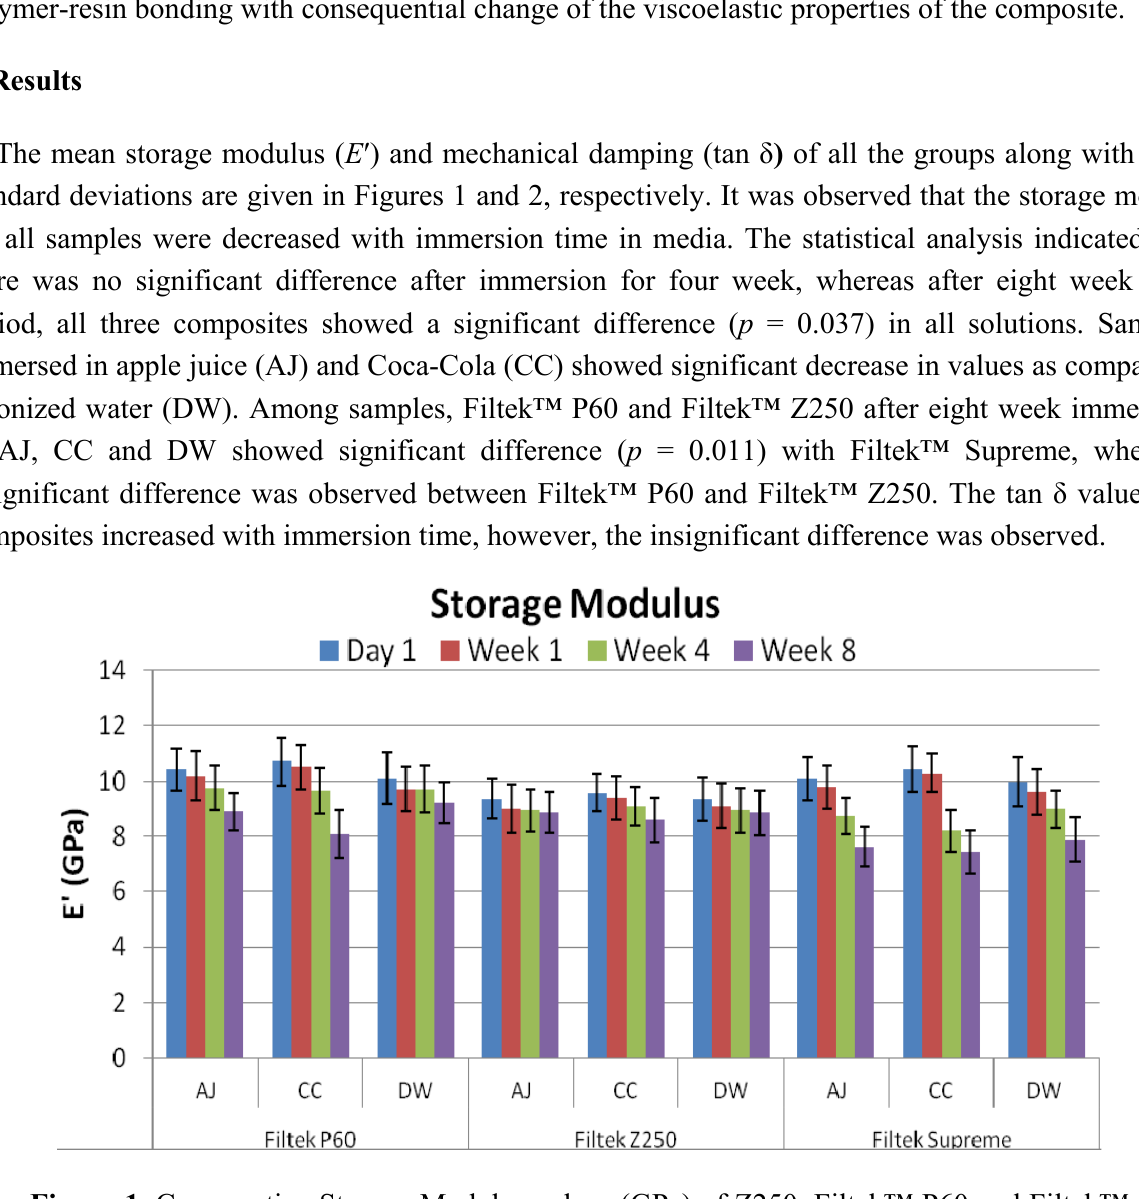
Figure 1. Comparative Storage Modulus values (GPa) of Z250, Filtek™ P60 and Filtek™ Supreme after immersion in apple juice (AJ), Coca-Cola (CC) and deionized water (DW) for one day, one week, four week, and eight